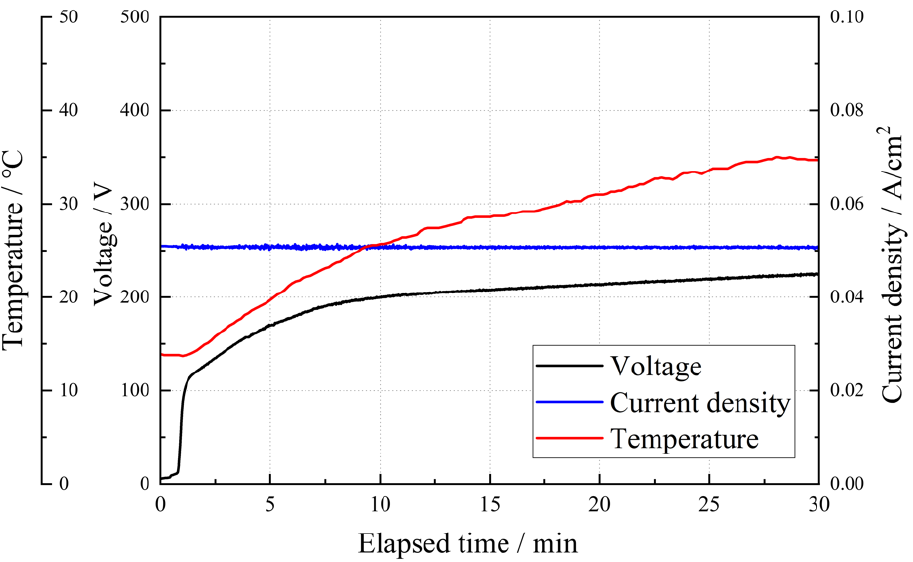
Figure 2. Changes in voltage, current, and temperature during anodic oxidation. Variation in the voltage, current density, and temperature against time during anodization in 1 M sulfuric acid electrolytes on the TiNbSn substrate.